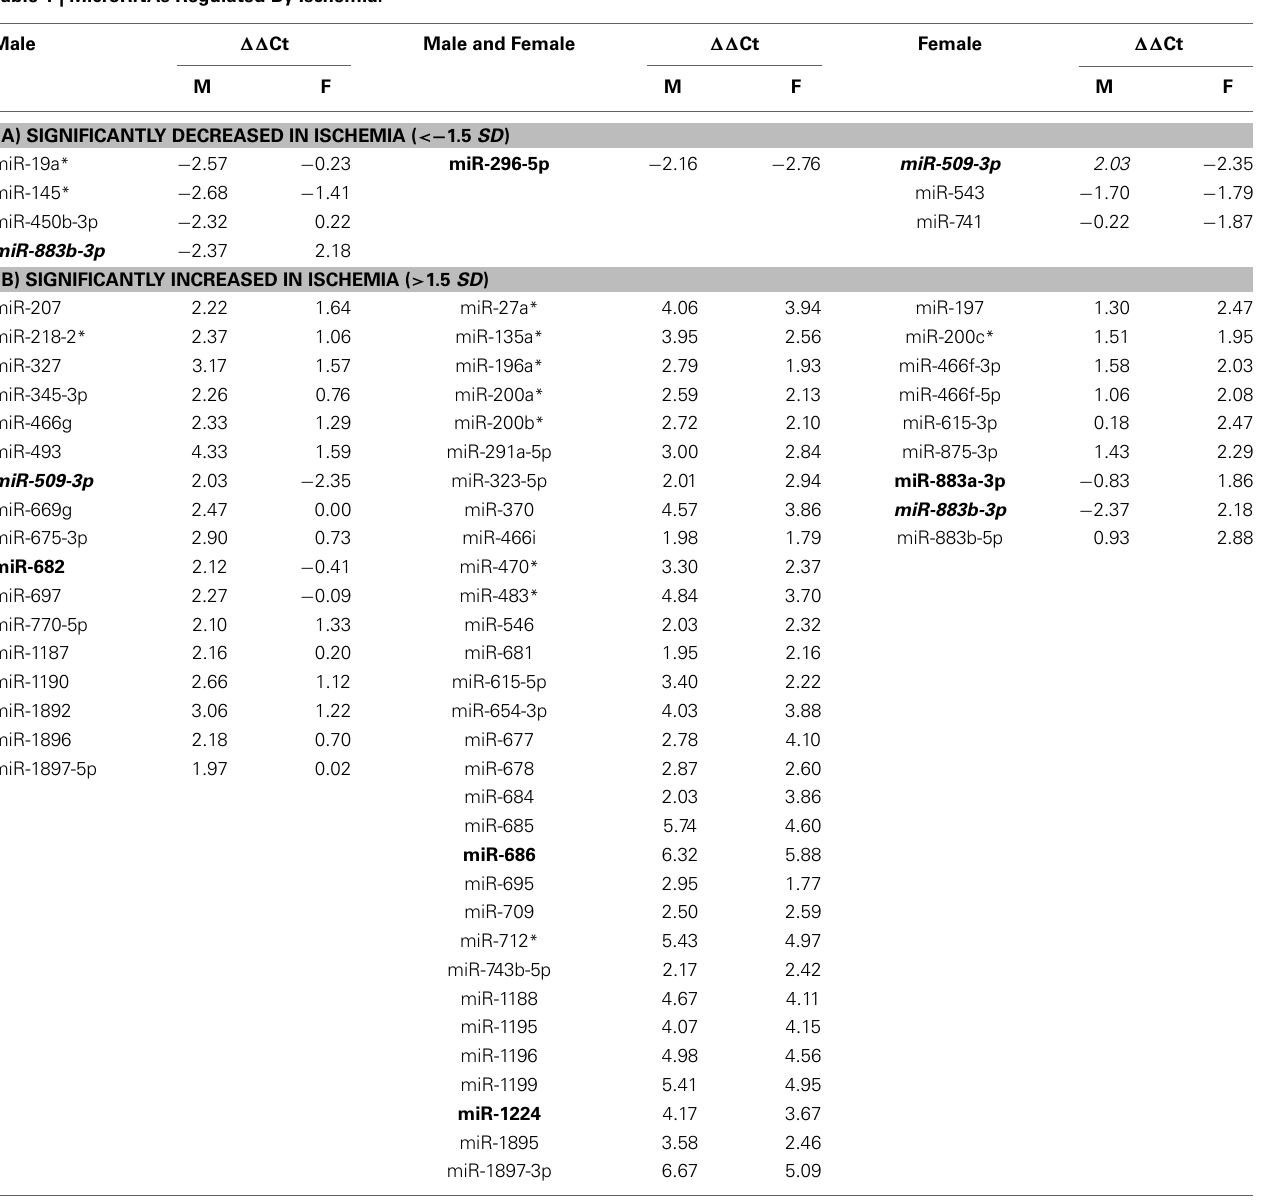
Table 1 | MicroRNAs Regulated By